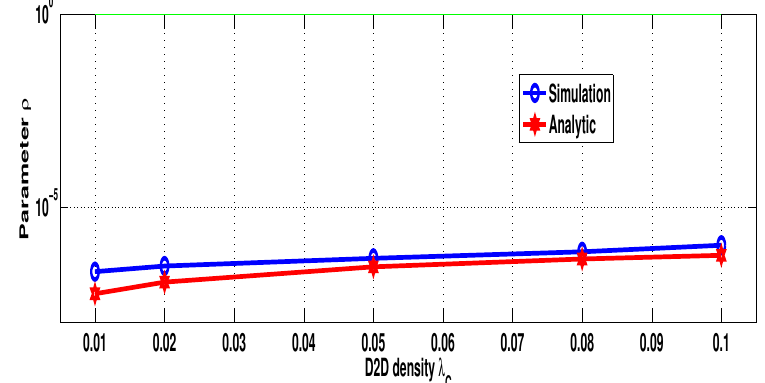
Figure 5. CDF of the transmit power for different values of m .